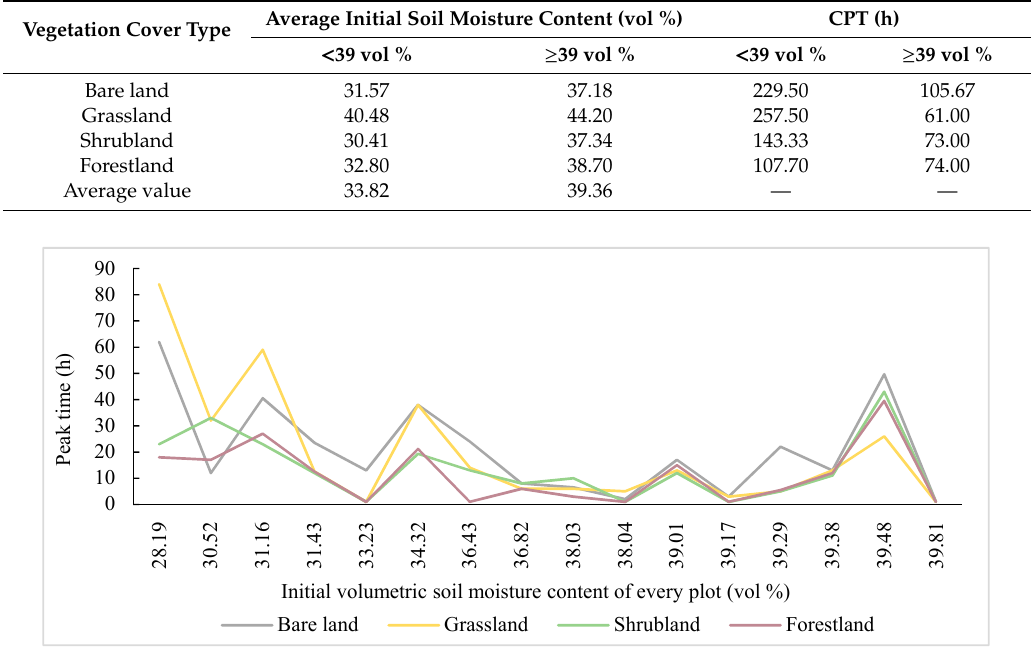
Figure 6. Comparison of peak volumetric soil moisture times of the different vegetation types.